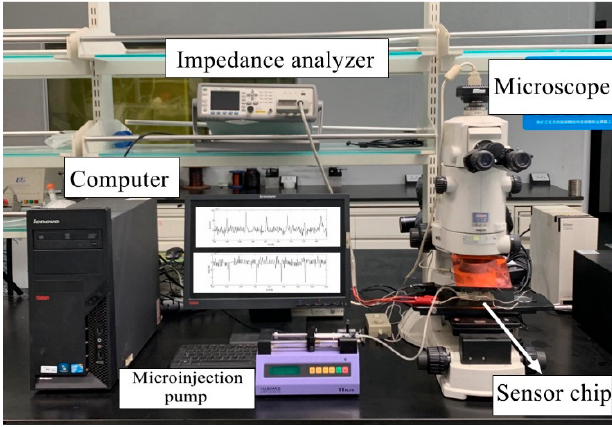
Figure 5. Photograph of the experimental system set-up.